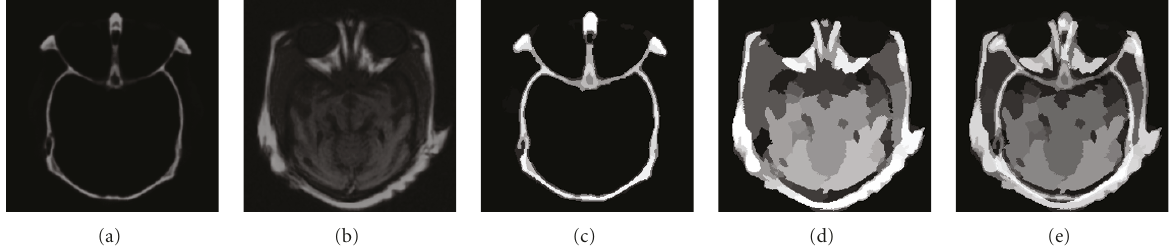
Figure 7: (a) and (b) Original “brain” source images, (c) mean-shift segmentation result of (a), (d) mean-shift segmentation result of (b), (e) shared region representation for region-based image fusion.